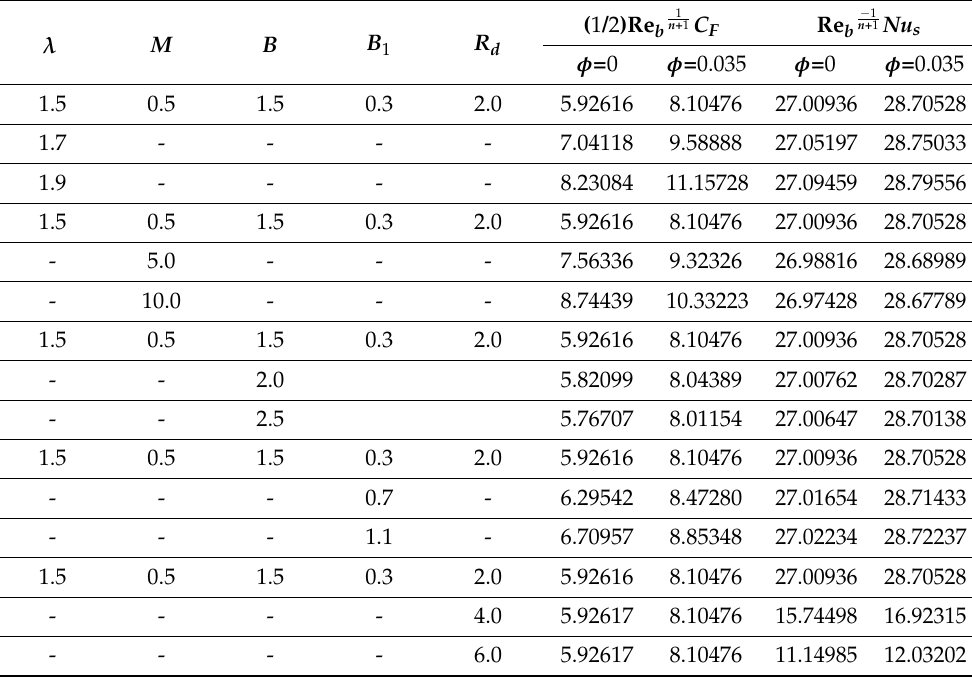
Table 4. Skin friction coefficient ters at Pr = 21, n = 2, S = 3.5, and B 2 =